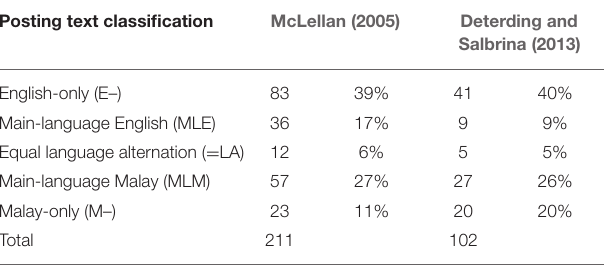
TABLE 1 | Language choice in two Brunei online discussion